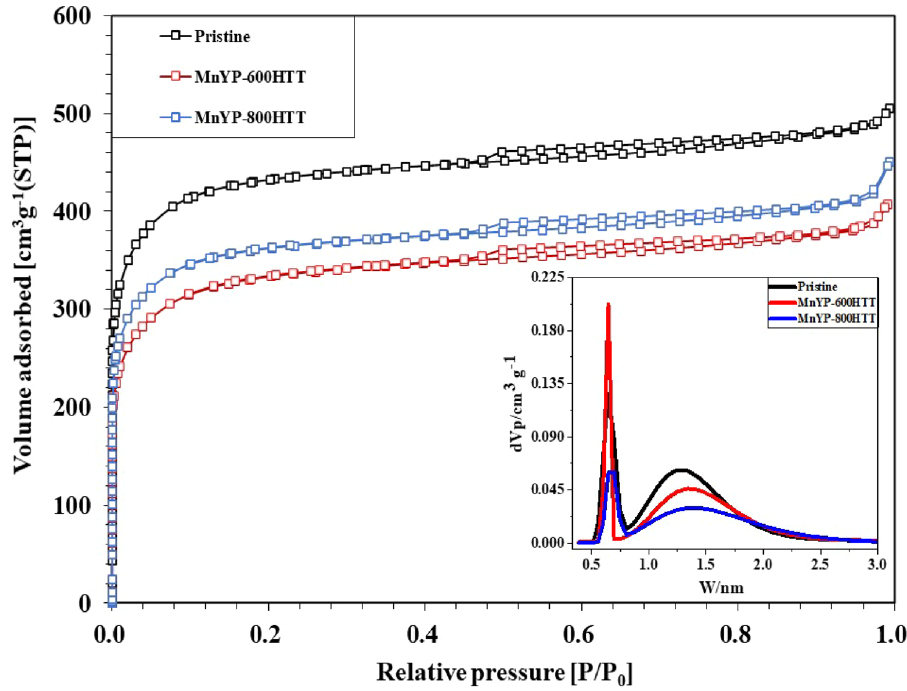
Figure 6. Nitrogen adsorption–desorption isotherms of Pristine, Mn-doped MnYP-600HTT and MnYP- 800HTT.